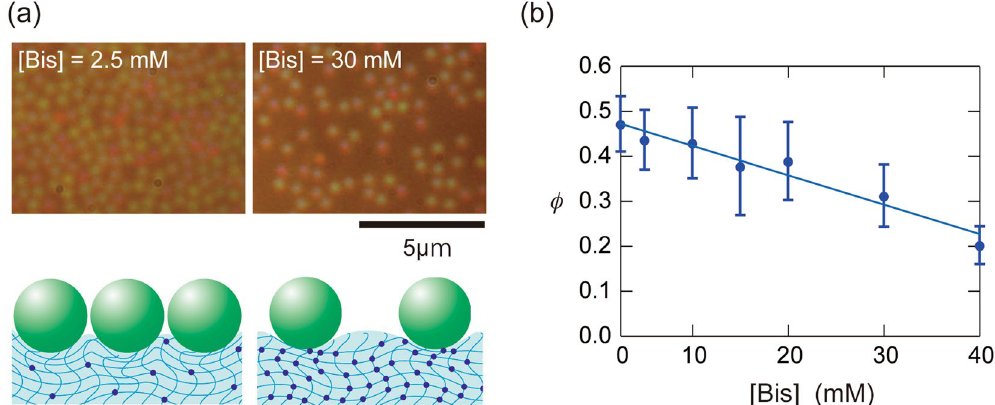
Figure 4. ( a ) Micrographs of adsorbed silica 1 particles on PAAm gel prepared for two values of [Bis] in water, and illustration of the adsorption states; ( b ) φ vs. [Bis] plot. Error bars represent standard